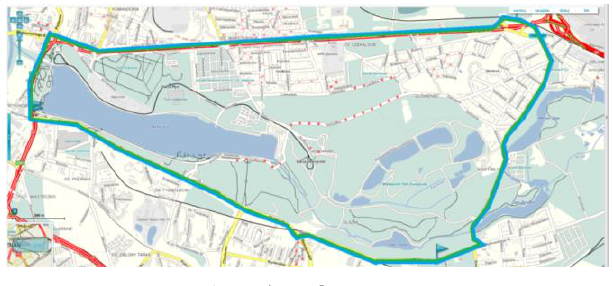
Fig. 2. The Malta test route